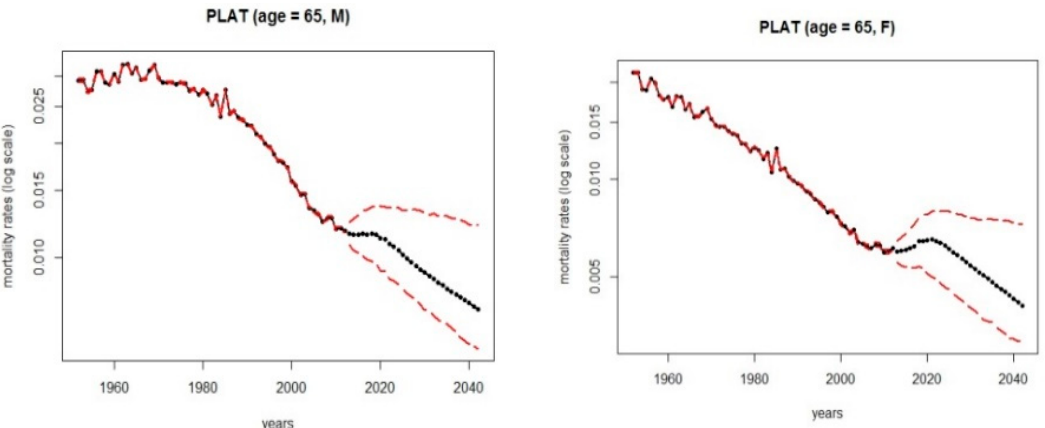
Figure 5. Fitted and Predicted death rates and bootstrap prediction intervals.